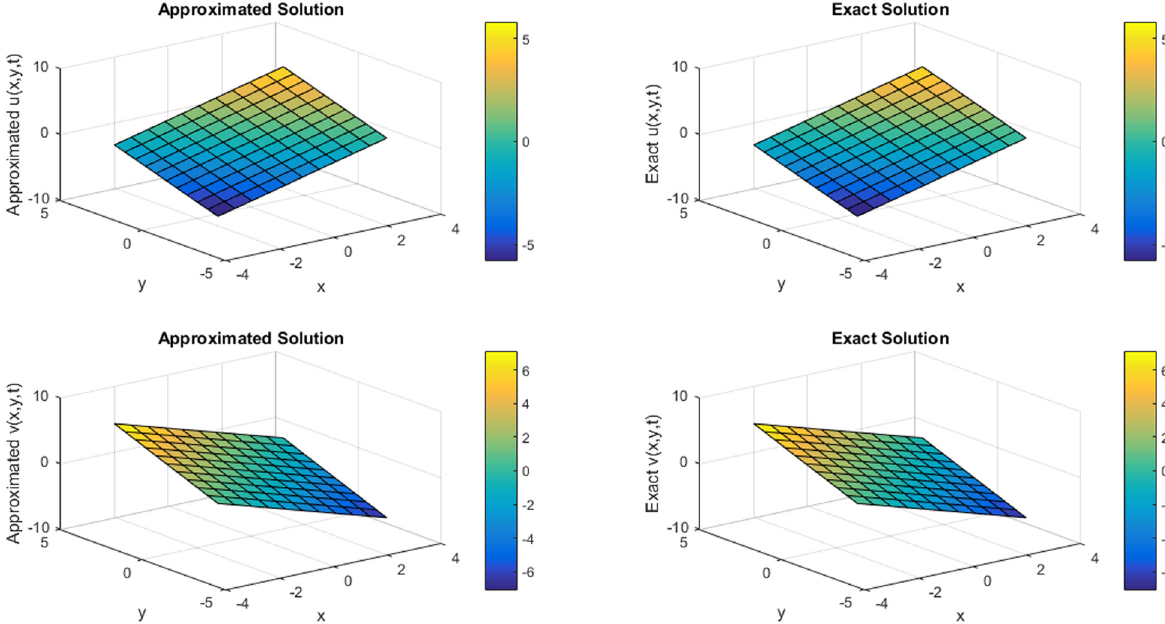
Figure 3: 3D plot for comparison of approximated and exact solutions of ϕ and ψ components at t = 0.1 for N = 11 regarding Example 2.